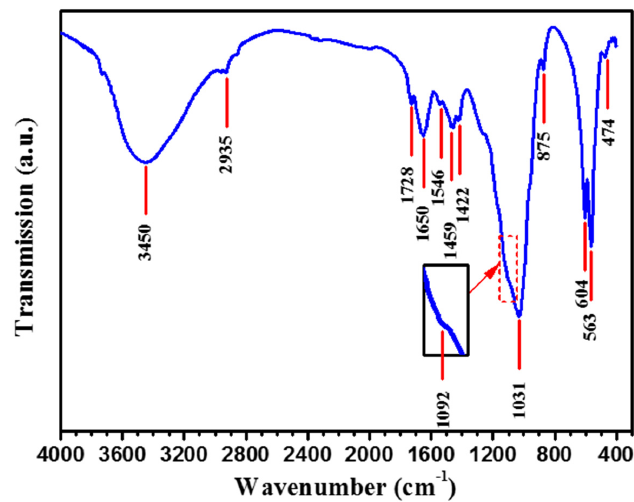
Figure 14. FT ‐ IR spectrum of the precipitated layer on the surface of the β‐ Ta coating after immersion in Hank’s solution for seven days. in Hank’s solution for seven